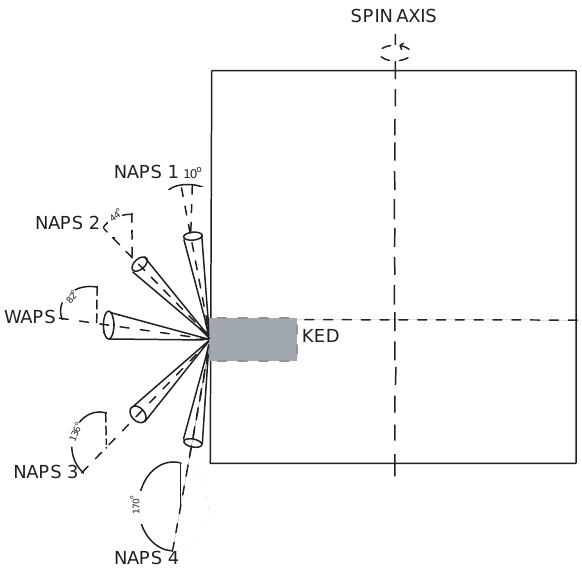
Fig. 2. The scanning ranges of the KED instrument onboard the ISEE-2 satellite. The contribution of each detector depends on the operational mode of the